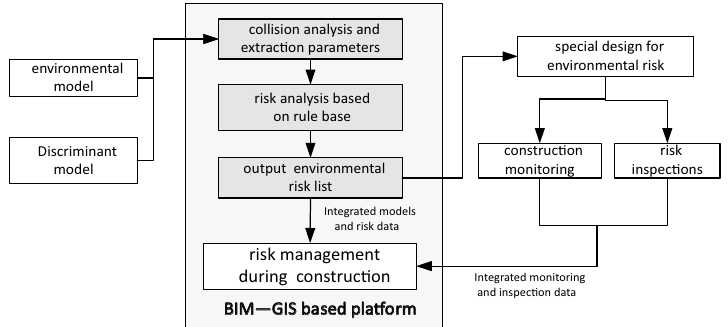
Figure 9. Framework for environmental risk automatic identification and